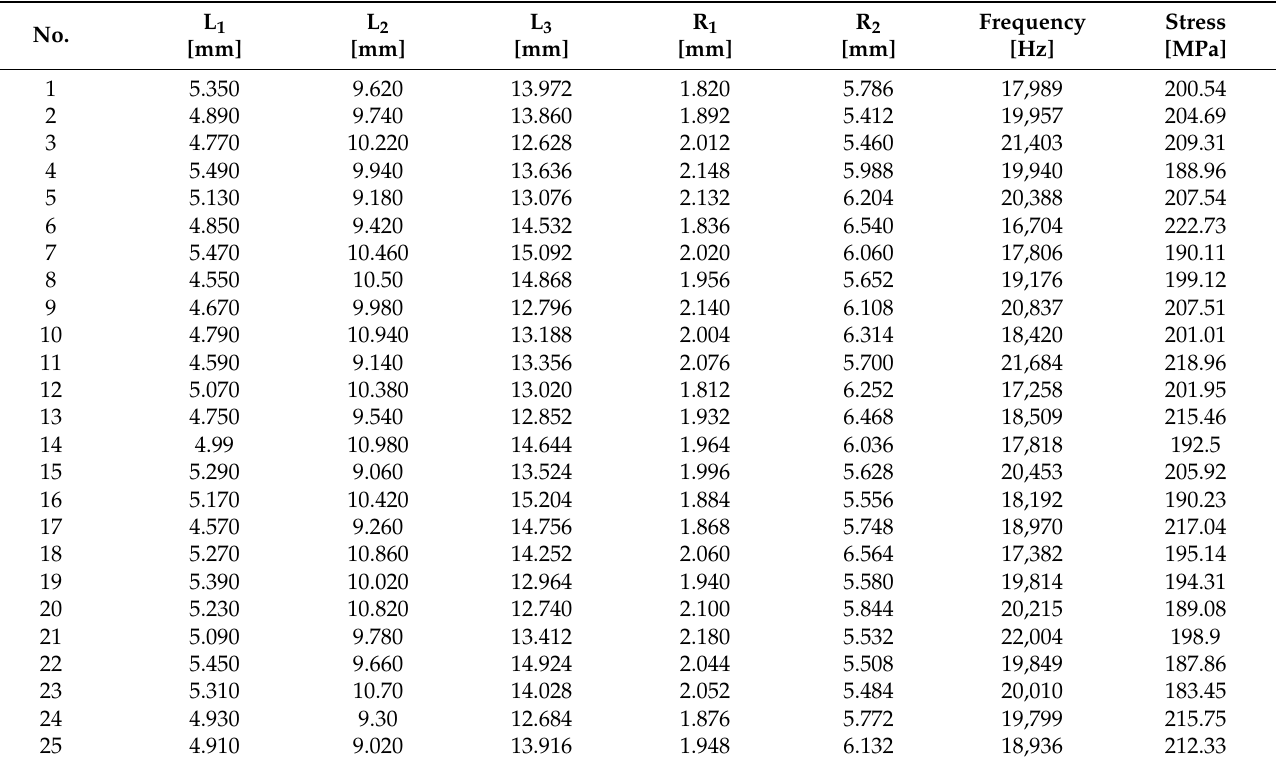
Table 3. Table of the range of variation of the dimensional parameters of the